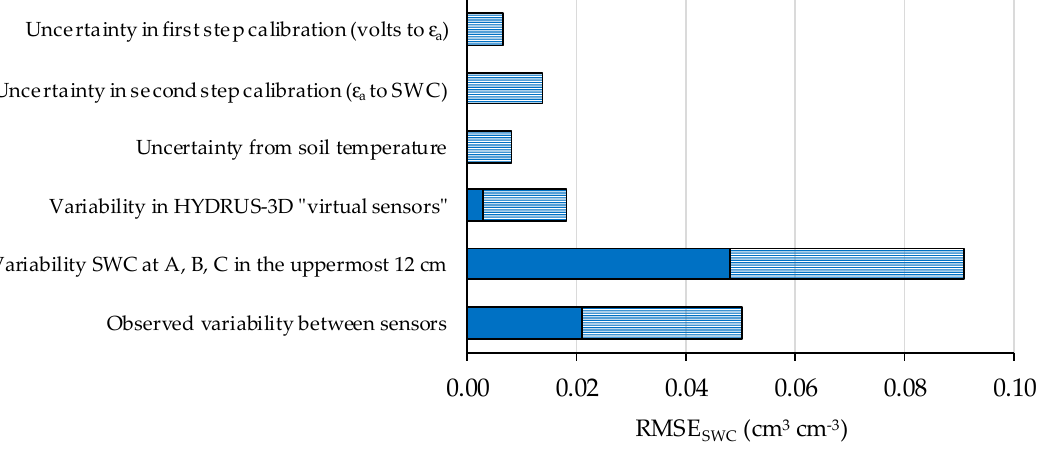
Figure 15. Ranges of uncertainty and variability in the measurement of soil water content (SWC) by capacitance sensors. Dark blue indicates least variability and light blue indicates maximum variability/uncertainty.